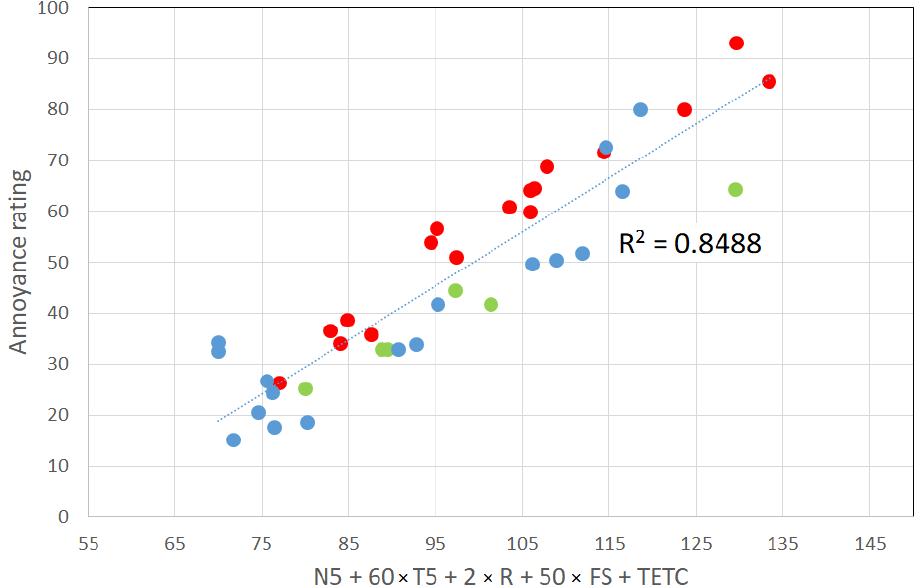
Figure 8. The relationship between perceived annoyance ratings and the annoyance index, which is the combination of the psychoacoustical properties from the Equation (1) and the TETC index. (Red dots: ICE cars, green dots: hybrid cars, and blue dots: electric cars).